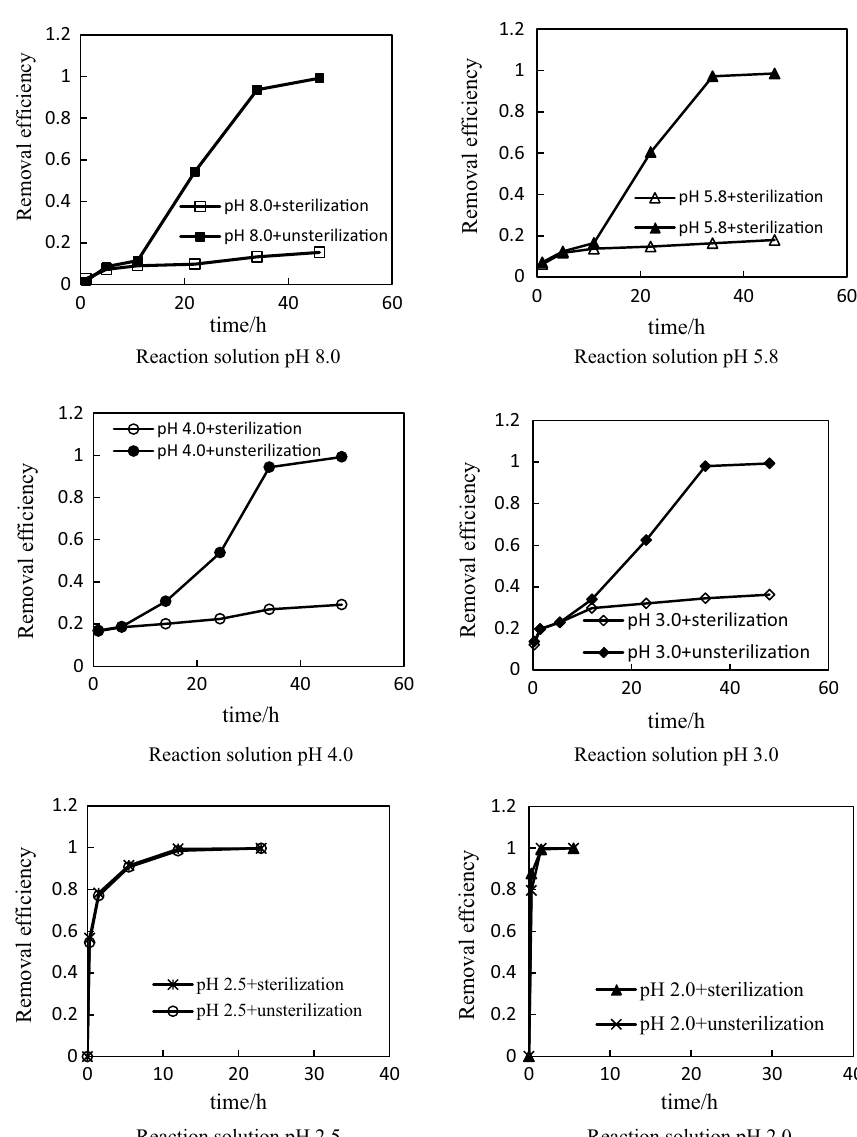
Reaction solution pH